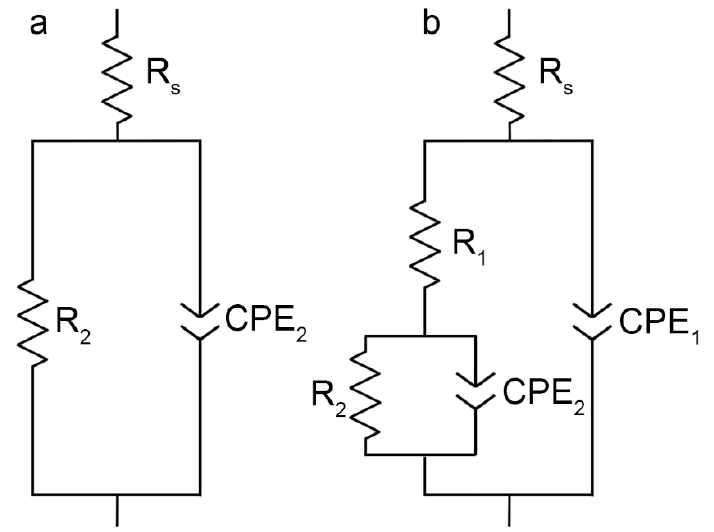
Figure 15. Equivalent electrical circuits, consisting of: ( a ) One R-CPE -circuit, and ( b ) two R-CPE -circuits. EEC were used for the EIS experimental results’ simulation (Figure 14) using fitting parameters (Table 3).